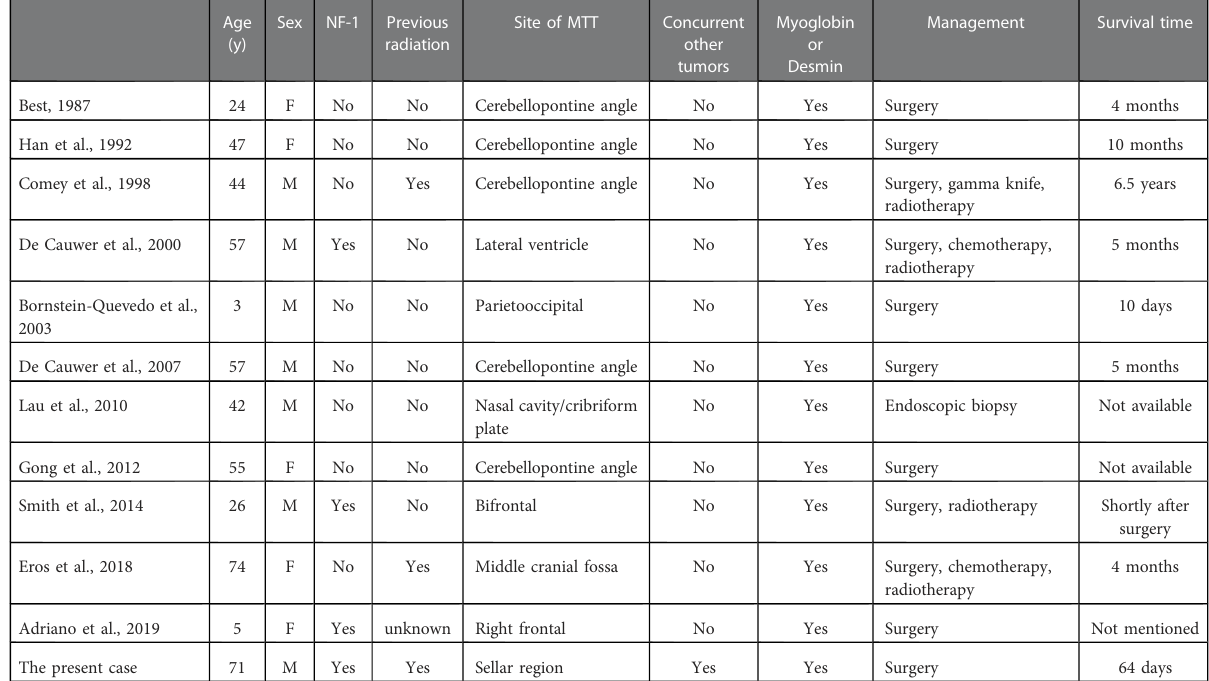
TABLE 1 Summary of reports of intracranial malignant triton tumors